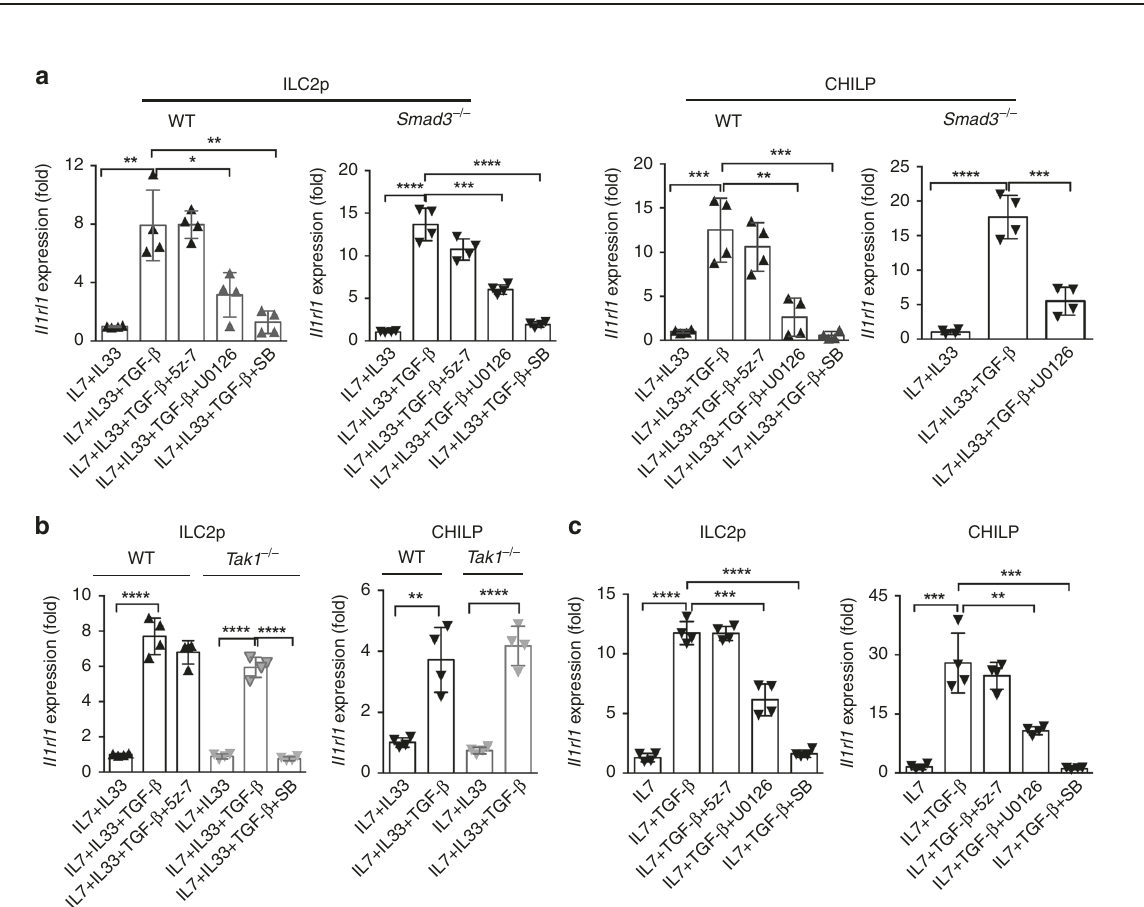
Fig. 5 TGF- β increases Il1rl1 mRNA in BM ILC2 precursors partially through MEK-dependent pathway. a Quantitative RT-PCR analysis of the gene expression of Il1rl1 in puri fi ed ILC2p and CHILP from WT and Smad3 − / − mice cultured in medium containing IL-7 and IL-33, performed 24 h after treatment with TGF- β 1 or TGF- β 1 and indicated inhibitors, and normalized to Hprt1 expression. b Il1rl1 mRNA expression in puri fi ed WT or TAK1-de fi cient ILC2p and CHILP cultured in IL-7 and IL-33 containing condition, performed 24 h after treatment with TGF- β 1 or TGF- β 1 and indicated inhibitors, and normalized to Hprt1 expression. c Il1rl1 mRNA expression in WT ILC2p and CHILP cultured in medium containing only IL-7, performed 24 h after treatment with TGF- β 1 or TGF- β 1 and indicated inhibitors, and normalized to Hprt1 expression. In each experiment, the BM cells were pooled from ten mice in each group before the cultures. Data are pooled from two independent experiments and are presented as mean ± SD. * p < 0.05, ** p < 0.01, *** p < 0.001, **** p < 0.0001 (Student ’ s t